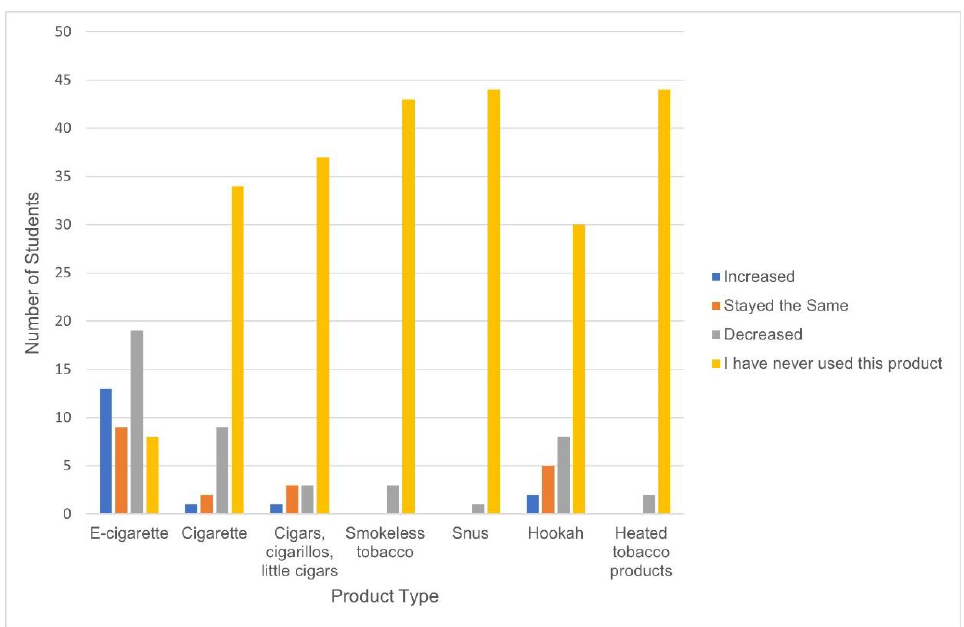
Figure 1. Product use behavior change due to the COVID-19 pandemic, NJYTS 2021 (n =